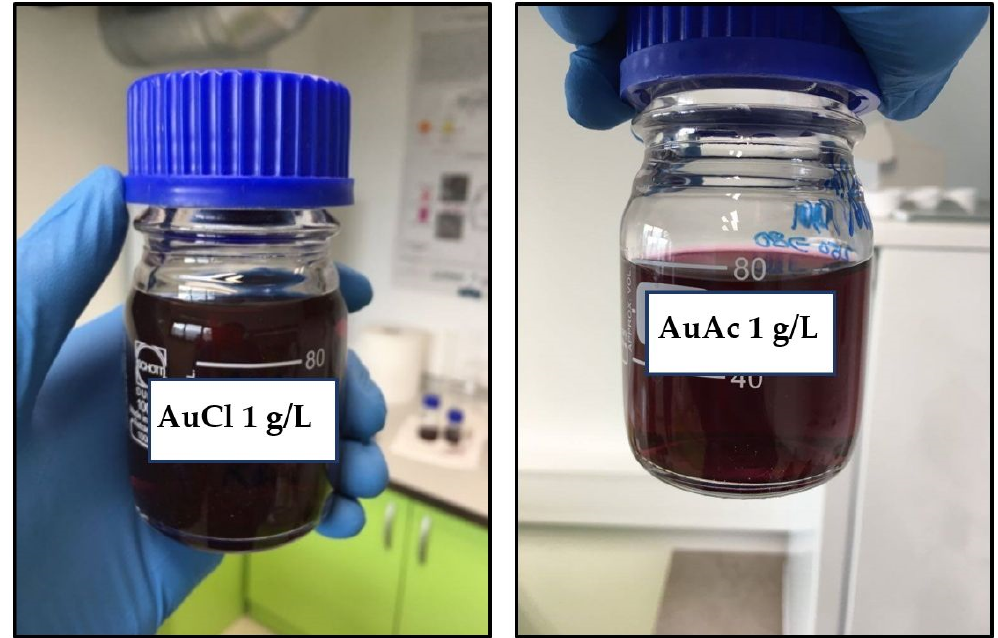
Figure 2. Prepared gold inks gold (III) chloride tetrahydrate (AuCl) and Au acetate salt (AuAc) with Au concentration of 1 g/L in the precursor.